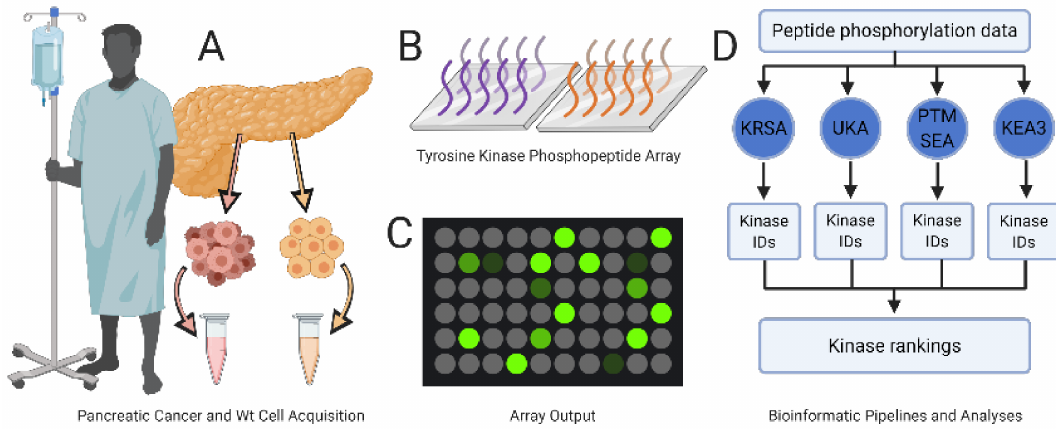
Figure 1. Experimental design. ( A ) Patient-derived pancreatic cancer cells (light red) and wild-type pancreatic tissue specimens (yellow) are processed and diluted to a uniform protein concentration. ( B ) Samples are added to the PamChip array containing 196 consensus phosphopeptide sequences immobilized on porous ceramic membranes; two (purple and orange) such sequences are illustrated here. ( C ) Quantification of peptide phosphorylation levels. ( D ) Peptide phosphorylation data are analyzed with each of four independent bioinformatic pipelines (KRSA, UKA, PTM-SEA, KEA3) and then combined to generate a list of tyrosine protein kinases’